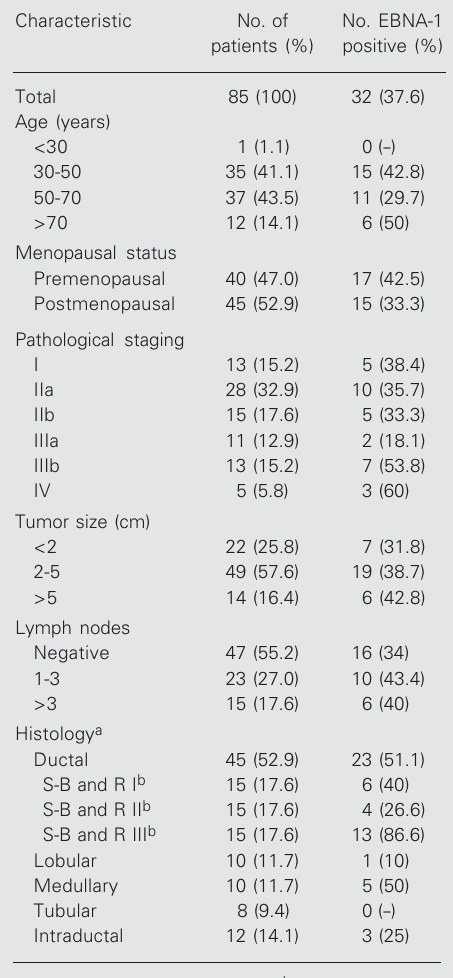
Table 1. Epstein-Barr virus EBNA-1 expression and characteristics of patients and tumors.